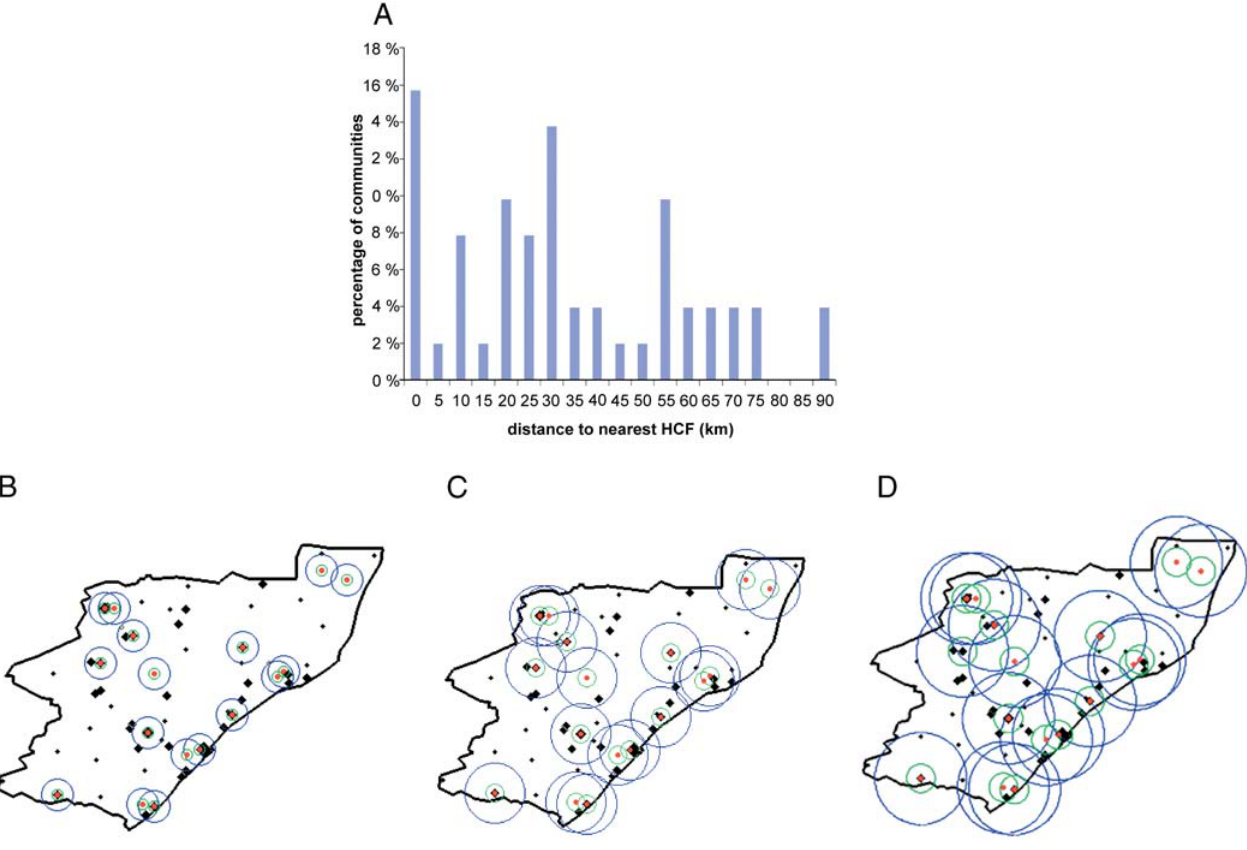
Figure 2. Accessibility of Communities to HCFs (A) A histogram indicating heterogeneity in the distance from communities in KwaZulu–Natal to the closest HCF. The treatment accessibility function used in our model is a Gaussian distribution, exp( (cid:1) kd 2 ), indicating that accessibility is strongly related to distance (d), and k is a dispersal length scale parameter. (B) The catchment region is shown with an effective radius of 20 km for coverage from each HCF ( k = 0.0151). (C) The catchment region is shown with an effective radius of 40 km for coverage from each HCF ( k = 0.003786). (D) The catchment region is shown with an effective radius of 60 km for coverage from each HCF ( k = 0.00168). In each case, the red dots indicate the location of the HCF, the green circles represent the locations where treatment accessibility has been reduced to 50% relative to someone located at the HCF, and the blue circles represent the locations where treatment accessibility has been reduced to 1% relative to someone located at the HCF. The locations of communities are presented as black diamonds. The large black diamonds denote large communities (with population greater than 10,000 people), and the small black diamonds denote small communities (with population less than 10,000 people). Substantially more area of the province is covered if HCFs have catchment regions of 60-km radius, relative to catchment regions of 40-km radius, and substantially less area of the province is covered if HCFs have a catchment region of only 20- km radius. However, the proportion of people with access does not differ greatly between the different catchment sizes because of the great spatial heterogeneity in the prevalence of people with HIV. DOI: